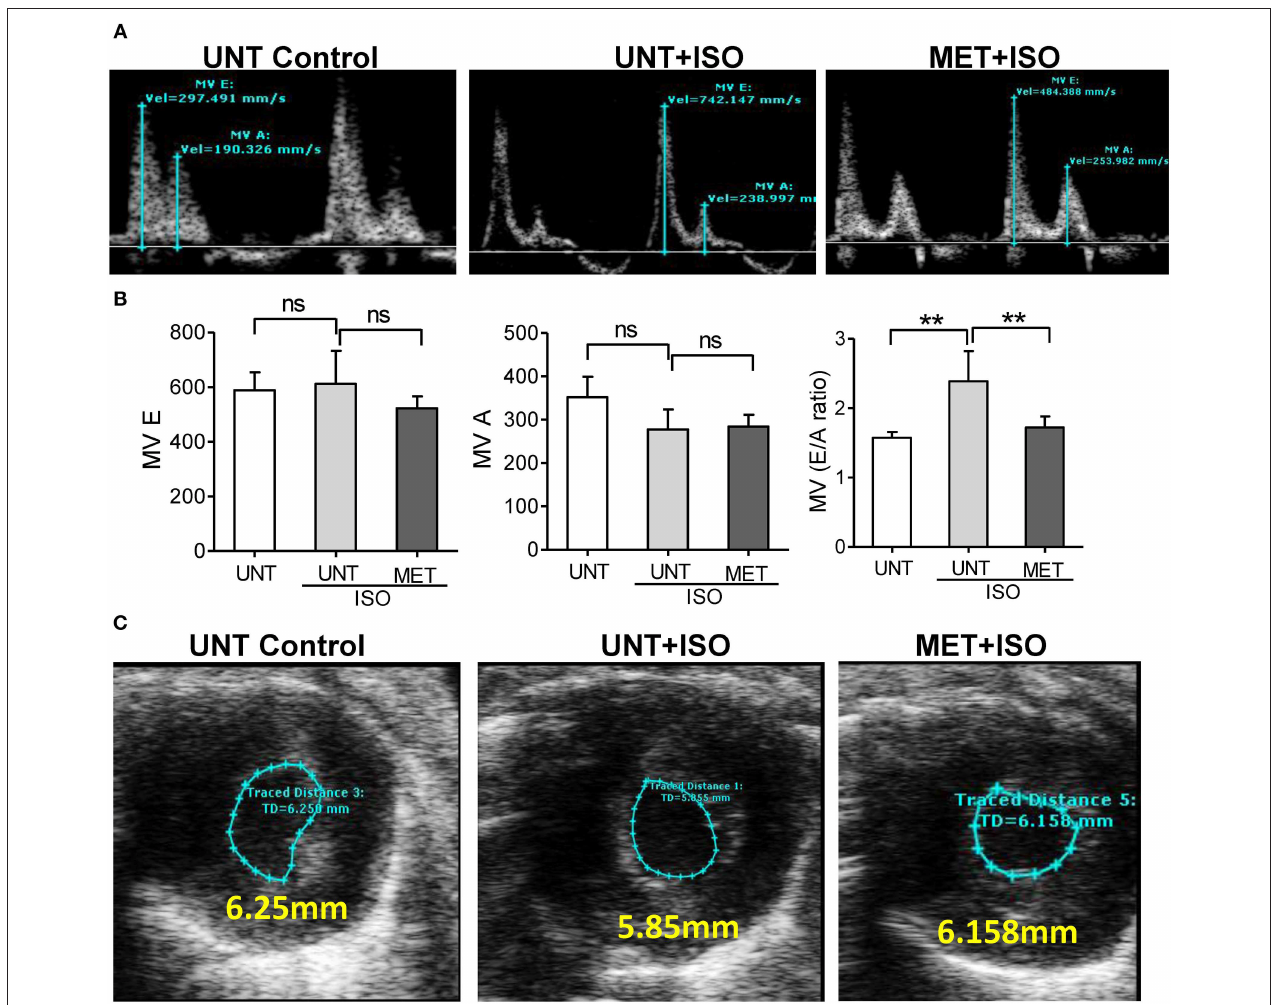
FIGURE 3 | Exercise training preserved normal diastolic function in the heart treated with Isoproterenol. (A) The mitral valve flow pattern was recorded by pulse wave Doppler mode using Vevo2100 high-resolution echocardiography, (B) Mitral valve filling velocities (MV E and A) were measured using Mitral valve images and represented as bar graph, C) The representative B-Mode of SAX image displaying the level of contraction, n = 5–6/group, values are represented as mean ± SD. Significance: ** p < 0.01; ns, no